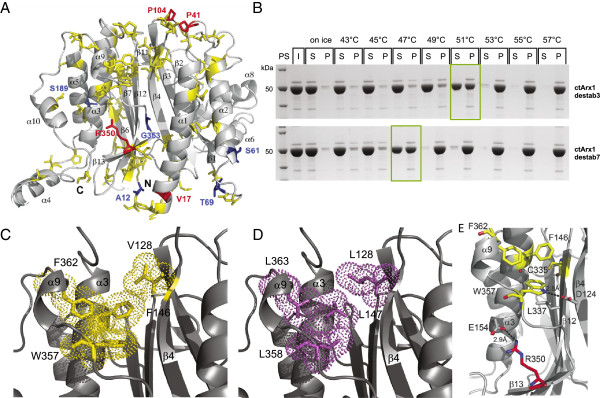
Hydrophobic core packing in the Arx1 protein. A) Ribbon representation of the ctArx1 structure. ctArx1 crystallized readily, whereas cgArx1 did not. Adaptive (destabilizing) and neutral (non-destabilizing) amino acids are highlighted in red and blue, respectively. The positions of amino acids, which differ between the cg and ctArx1 proteins, are marked in yellow. The positions of the ctArx1 specific cysteines, C249 and C335, and the prolines, P135 and P182, are indicated by stars and triangles respectively. The N- and C-termini of ctArx1 are indicated by ‘N’ and ‘C’. B) Mutation of a hydrophobic patch leads to reduced thermostability of ctArx1. Two ctArx1 mutant proteins containing mutations within the hydrophobic patch described in (C,D,E) are tested for their thermostability in comparison to wild-type ctArx1 at the indicated temperatures and at a protein concentration of 8 mg/ml. ctArx1-destab7 contains the five destabilizing mutations of ctArx1-destab (Figure 4B) and two mutated hydrophobic residues (F146L, W357L), ctArx1-destab3 contains F146L, W357L, and the destabilizing mutation R350K. C) A closed hydrophobic stretch of exchanged amino acids in ctArx1 increases the contact between secondary structure elements and close a surface groove in ctArx1. Val128, Phe146, Trp357 and Phe362 of ctArx1 are highlighted in yellow. D) The corresponding modeled amino acid residues of cgArx1, Leu128, Leu147, Leu358 and Leu363, are highlighted in magenta. In both panels the volumes of the residues are indicated with small dots. E) The adaption of ctArx1 to thermophily is achieved in part by the increase of hydrophobic density and polar/electrostatic contacts with the core of the protein’s scaffold. The adaptive amino acid Arg350 (Lys) is highlighted in red. Hydrophobic animo acids, which differ between the cg and ctArx1 proteins, are marked in yellow. Amino acid side chain interactions are indicated by black, dashed lines.